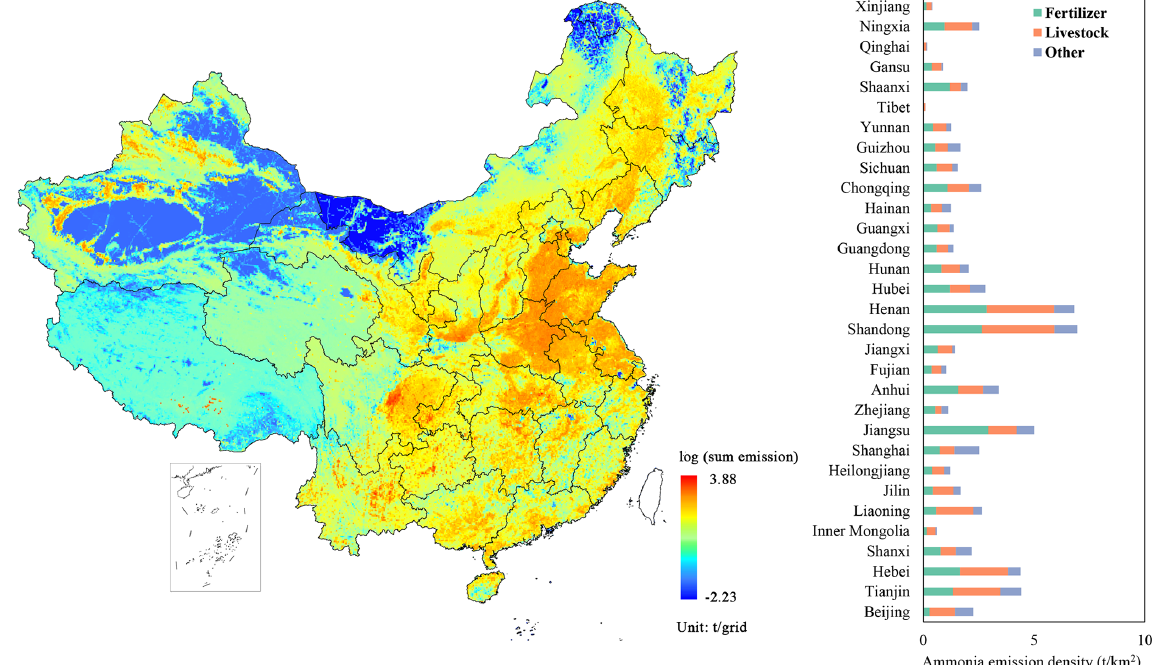
Figure 4. Geographical distribution of 2016 NH 3 emissions and emission densities in